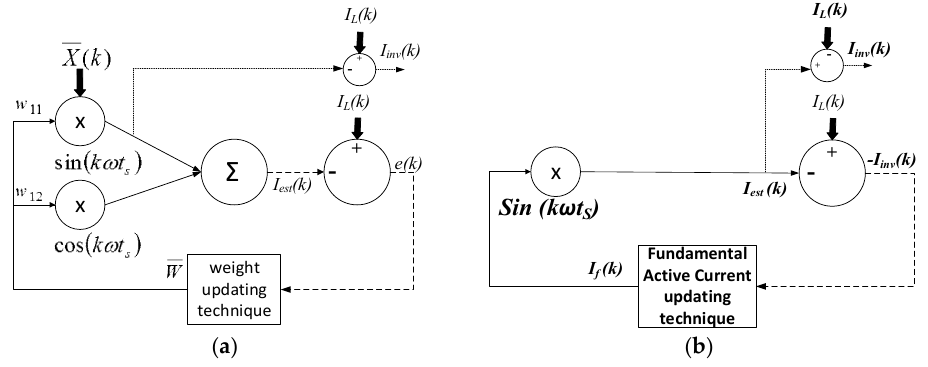
Figure 3. Block diagrams of ( a ) Modified Widrow–Hoff adaptive linear neuron (ADALINE) and ( b ) Simpler ADALINE algorithms.